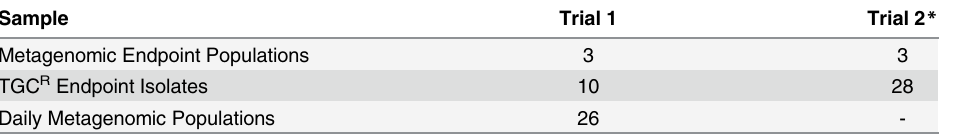
Table 1. Description of samples sequenced from two independent adaptation